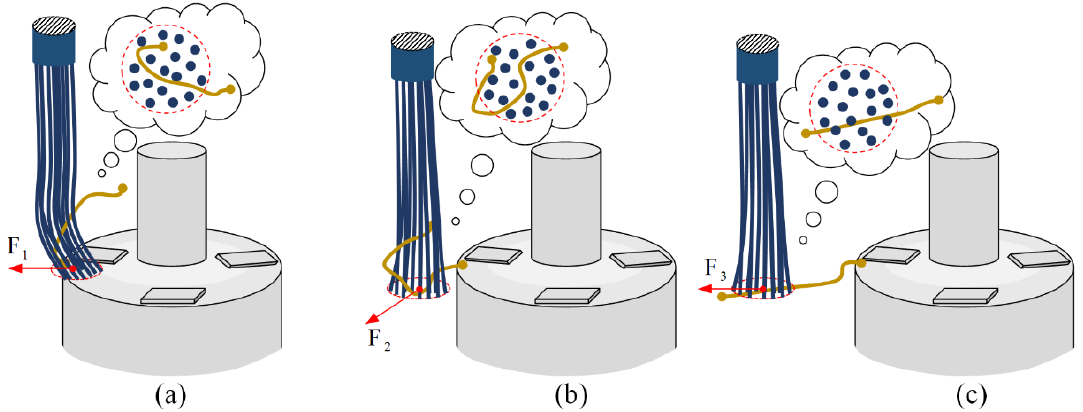
Figure 4. Three states in the working process of the horizontal brush: ( a ) The state of the horizontal brush in contact with the top of the winding. ( b ) The instantaneous state of the horizontal brush off the top of the winding. ( c ) The state of the horizontal brush with unfolded wire.